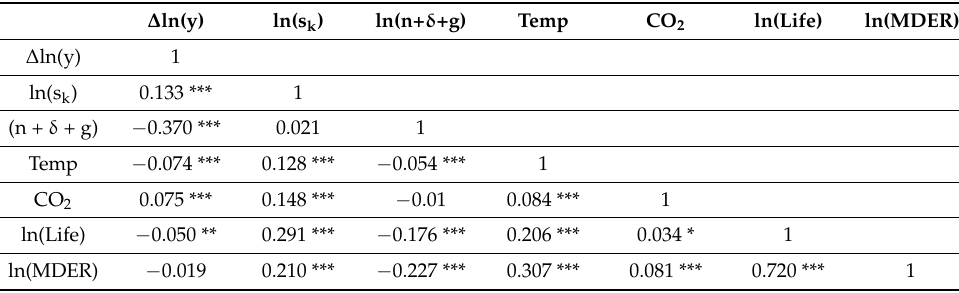
Table A2. Pairwise correlation matrix of dependent and independent